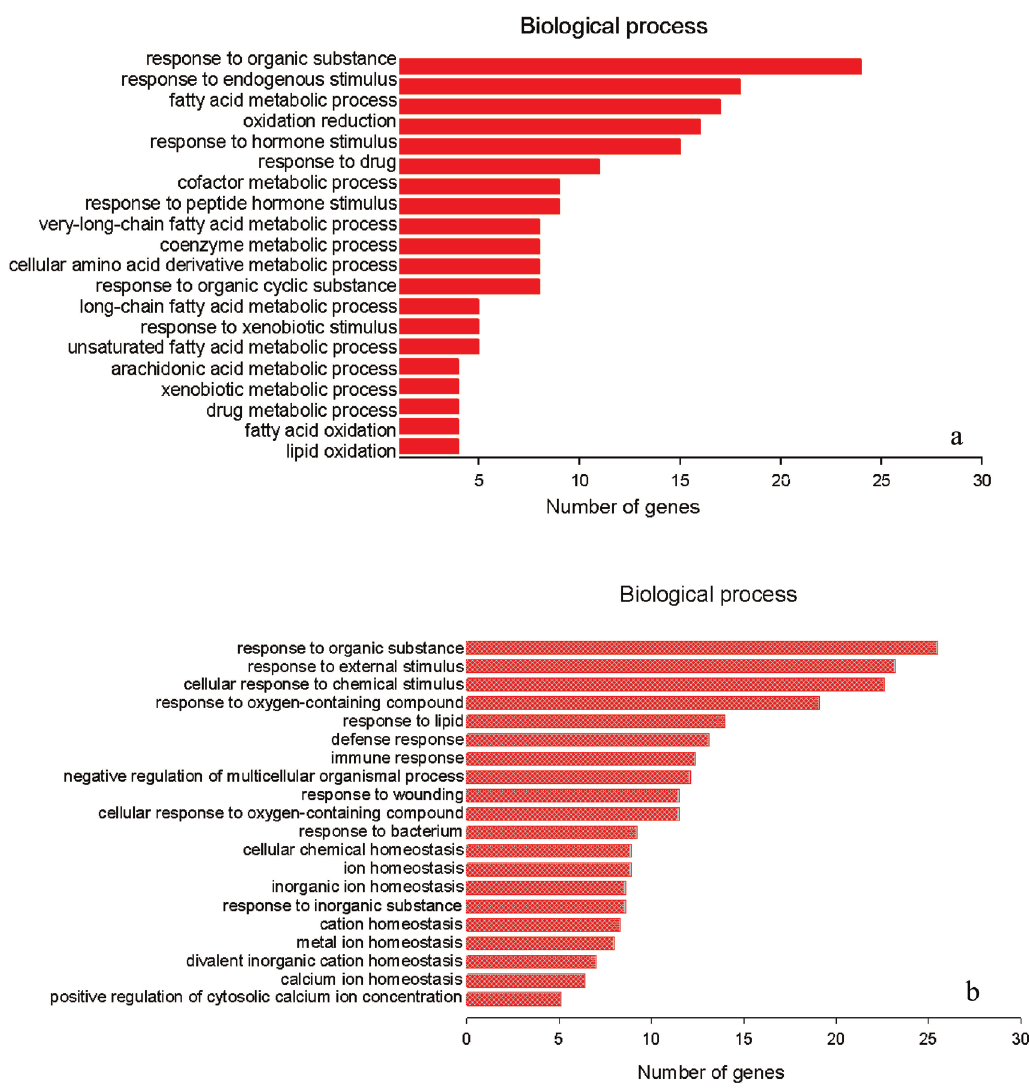
Figure 4 - The top 20 gene ontology (GO) biological process (BP) terms with the highest statistical significance. The vertical axis was the GO BP terms, and the horizontal axis was the number of genes. a ) The top 20 significant GO categories for significantly up-regulated DEGs in sub-group AT-EEP; b ) The top 20 significant GO categories for significantly down-regulated DEGs in sub-group